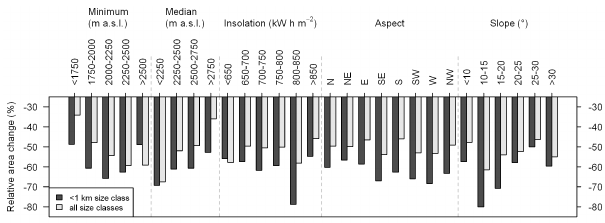
Fig. 8. Relative area change of glaciers in the study area for the period 1919–2006 as a function of different